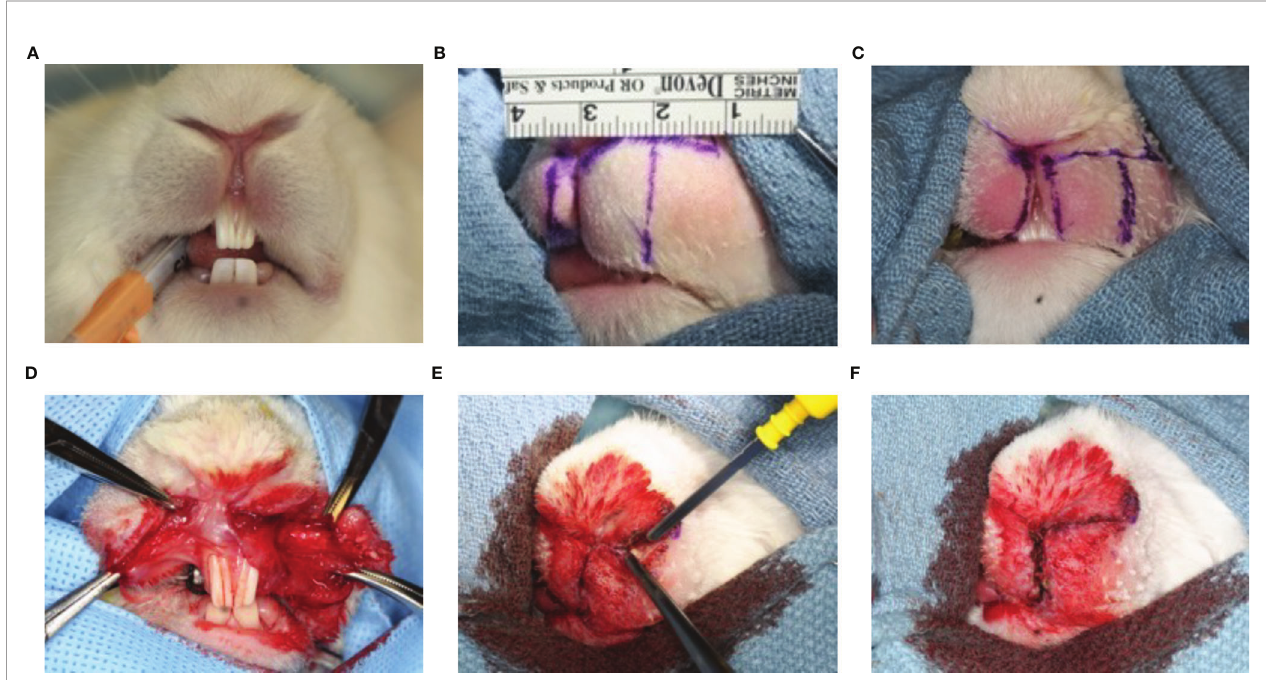
FIGURE 1 | Animal model of scarring after cleft lip repair. Anesthesia was maintained with iso fl urane 1-3% via endotracheal tube (A) . The upper lip on the left side was divided into two equal portions. The length of the upper lip of the left side was measured as the distance from the anterior border of the buccal pouch to the median line (B) . The medial portion of the upper lip on the left side was excised and a secondary releasing incision parallel to the upper lip on the left side was made (C) . A standardized rotation-advancement closure of the surgically induced cleft lip defect of the rabbit was performed with a passive adaptation of the fl ap (D) . The super fi cial skin edges were left open and lightly cauterized with electrocautery (also known as “ buttering ” ) to assure hemostasis and encourage scarring (E, F)